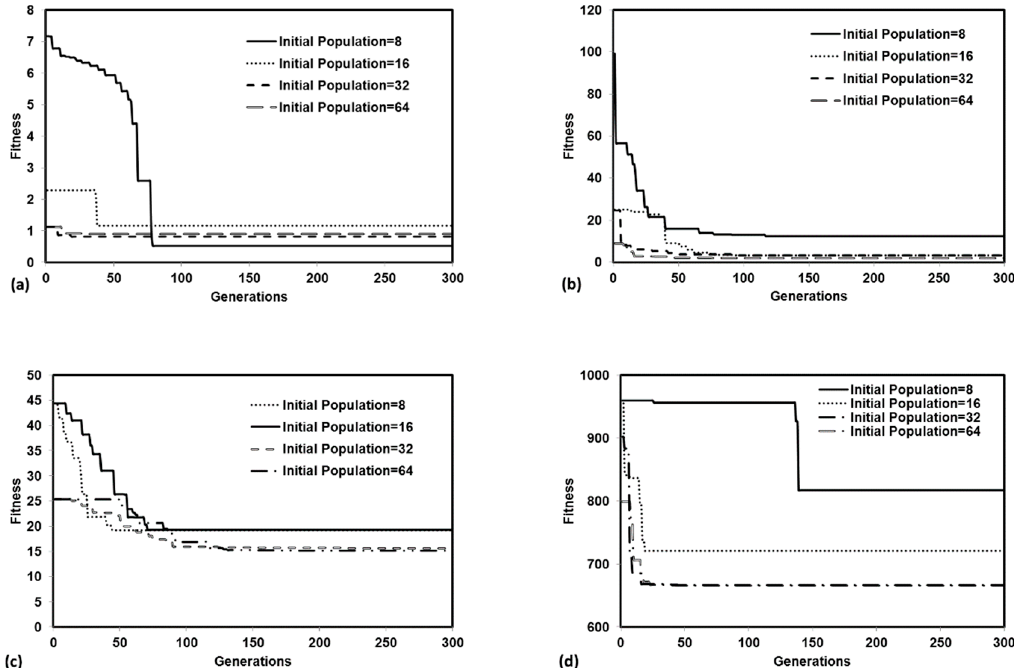
Figure 7. Change in best fitness at the end of each generation for different initial population sizes (8, 16, 32, 64) for ( a ) Benchmark problem 1, ( b ) Benchmark problem 2, ( c ) Benchmark problem 3, and ( d ) Benchmark problem 4.